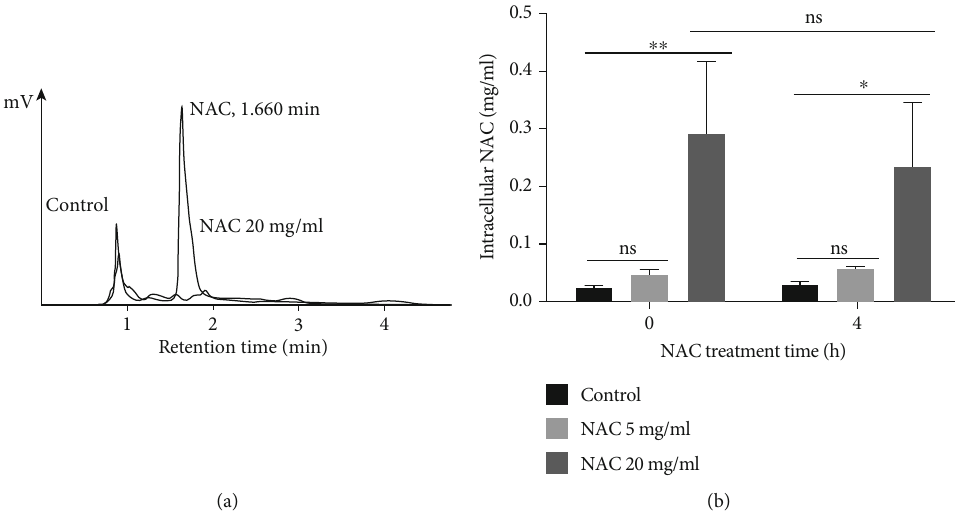
Figure 5: Detection of intracellular NAC using HPLC. 24h-bio fi lm was treated with 20, 5 or 0mg/ml NAC for 0 h or 4 h. After being collected and washed with PBS, cell pellets were sonicated to break the cell membrane and release intracellular NAC. The concentration of NAC was detected by an HPLC system equipped with a Phenomenex Luna C column ( 150 × 4 : 6 mm ; 5 μ m, 100 Å) and an UV/visible detector set at 18 214nm. (a) Retention time for NAC was at 1.660min. A standard curve was made with NAC concentrations ranging from 0 to 1mg/ml, and from this curve, peak areas are used to determine the concentration of NAC in the experiment. (b) After 20mg/ml NAC treatment for 0 and 4h, the concentrations of intracellular NAC were signi fi cantly higher than both control and 5 mg/ml NAC. Biological duplicates from each treatment were used for the quantitative